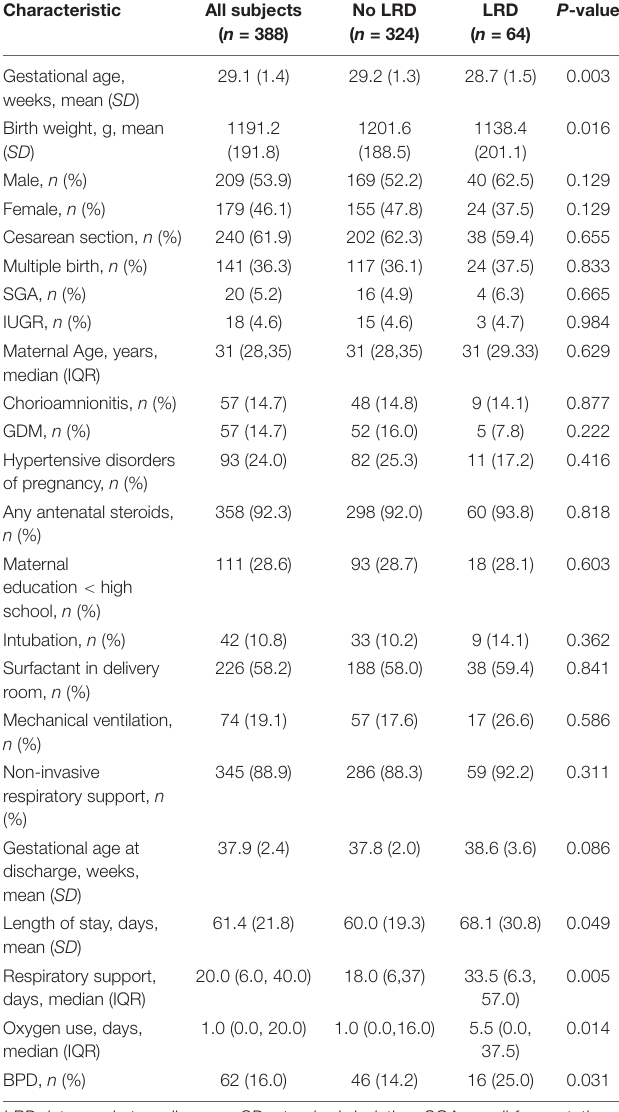
TABLE 1 | Characteristics of infants with and without late respiratory